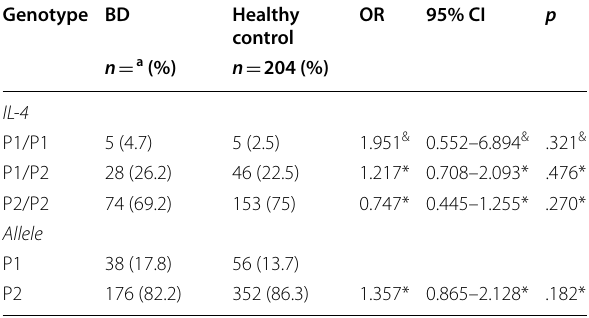
Table 5 Comparison of frequencies of the IL-4 VNTR polymorphism between BD patients and healthy